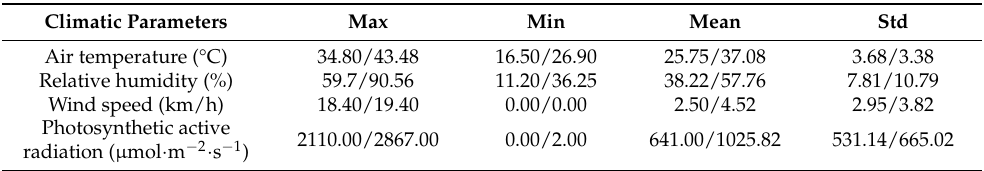
Table 2. Maximum (max), minimum (min), mean, and standard derivation (Std) of the climatic values for E1 and